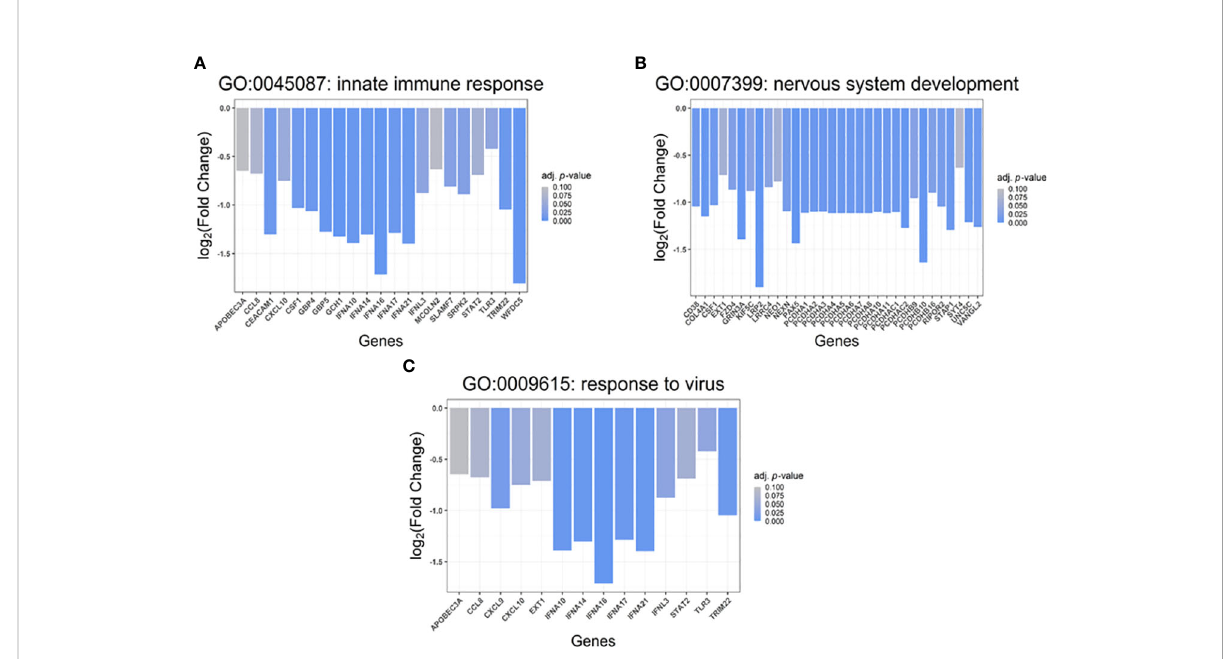
FIGURE 5 Gene set enrichment analysis (GSEA). Biological processes (Gene Ontology, GO: BP) associated with the identi fi ed, differentially up- and downregulated genes (p<0.05) in cells transfected with S protein-coding construct compared to mock control. (A) Genes involved in Innate